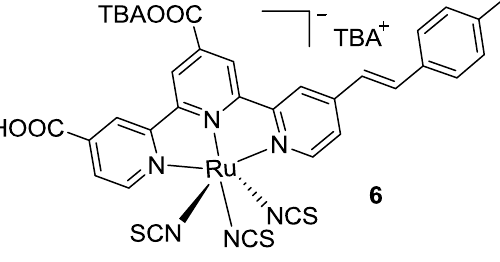
Figure 8. 4-Methylstyryl substituted and double-anchored tpy (HIS-2) [77].